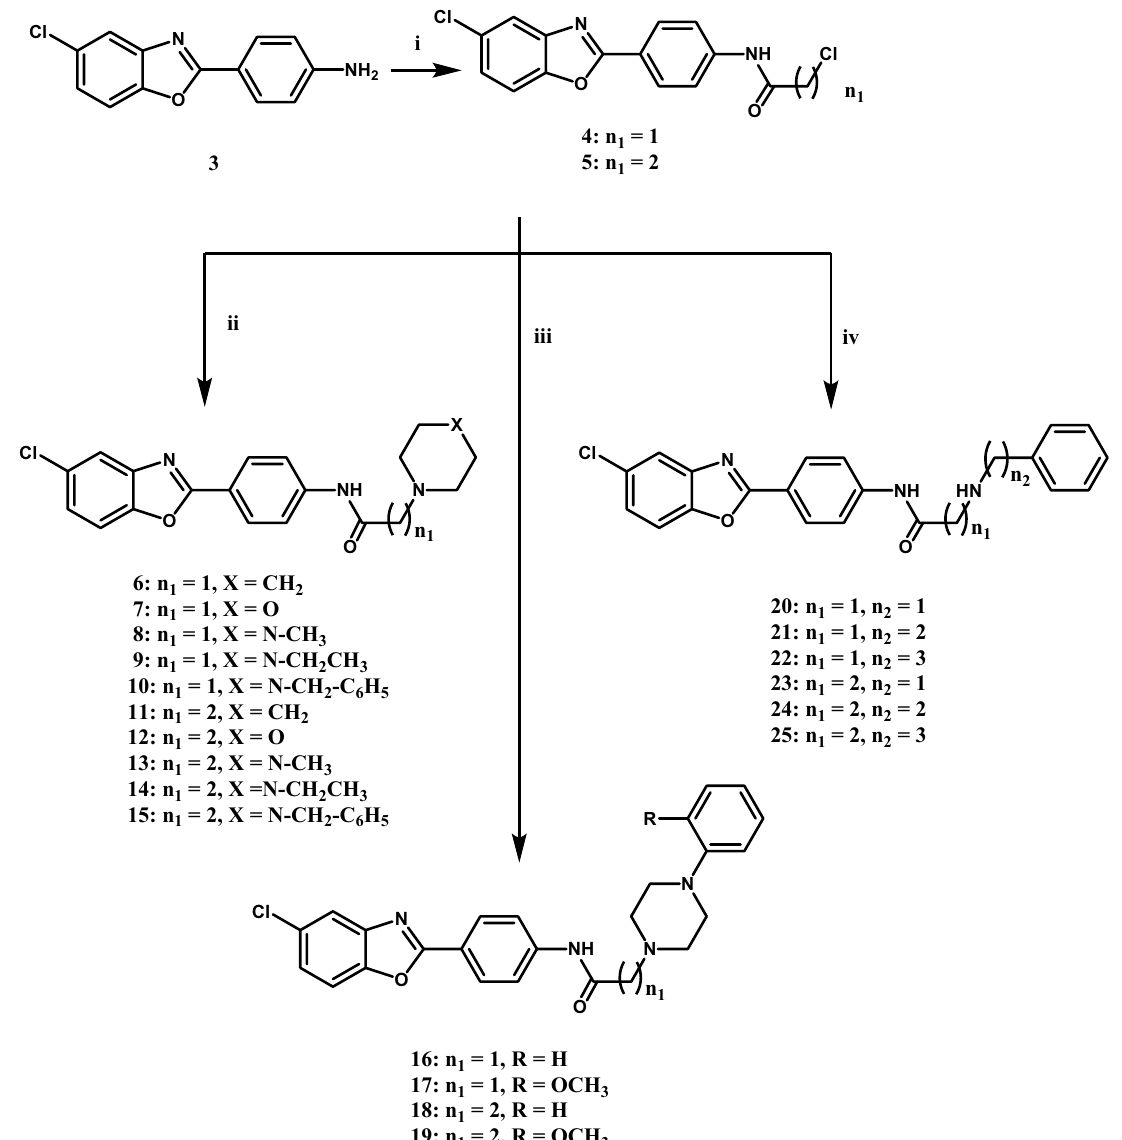
Figure 4. Synthetic scheme of target benzoxazole derivatives